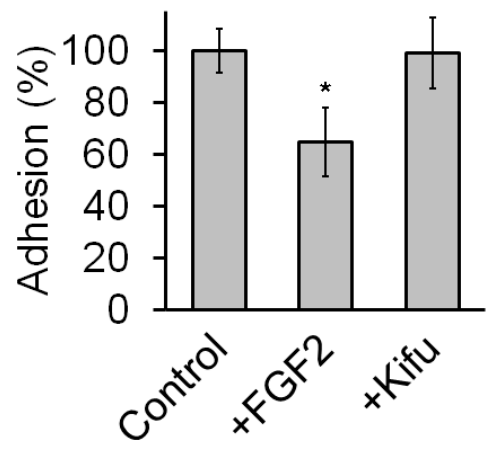
Figure A2. Treatment with Kifunensine does not seem to affect adhesion of MSCs to plastic. Adhesion assay on MSCs nontreated with either FGF2 or Kifunensine for 24 h. Cells were then lifted and let to attach over uncoated culture plates for 10 min ( n = 5). * p < 0.05.